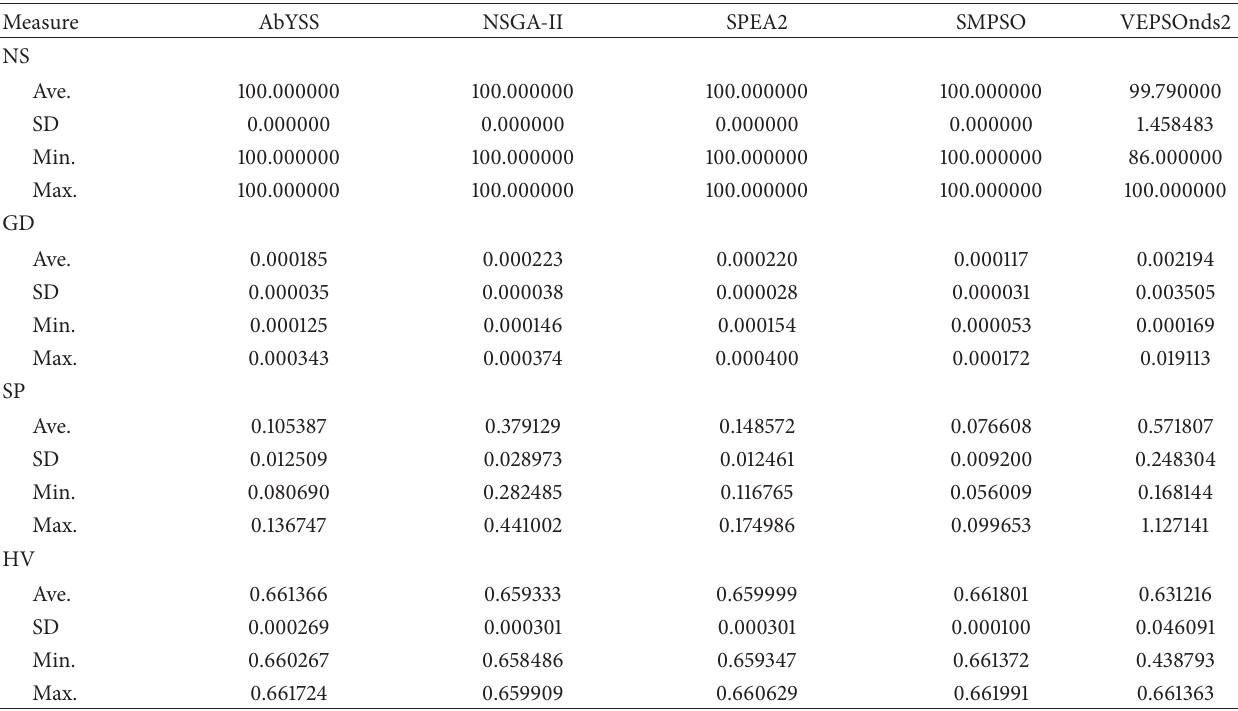
Table 6: Performance comparison based on ZDT1 test problem.